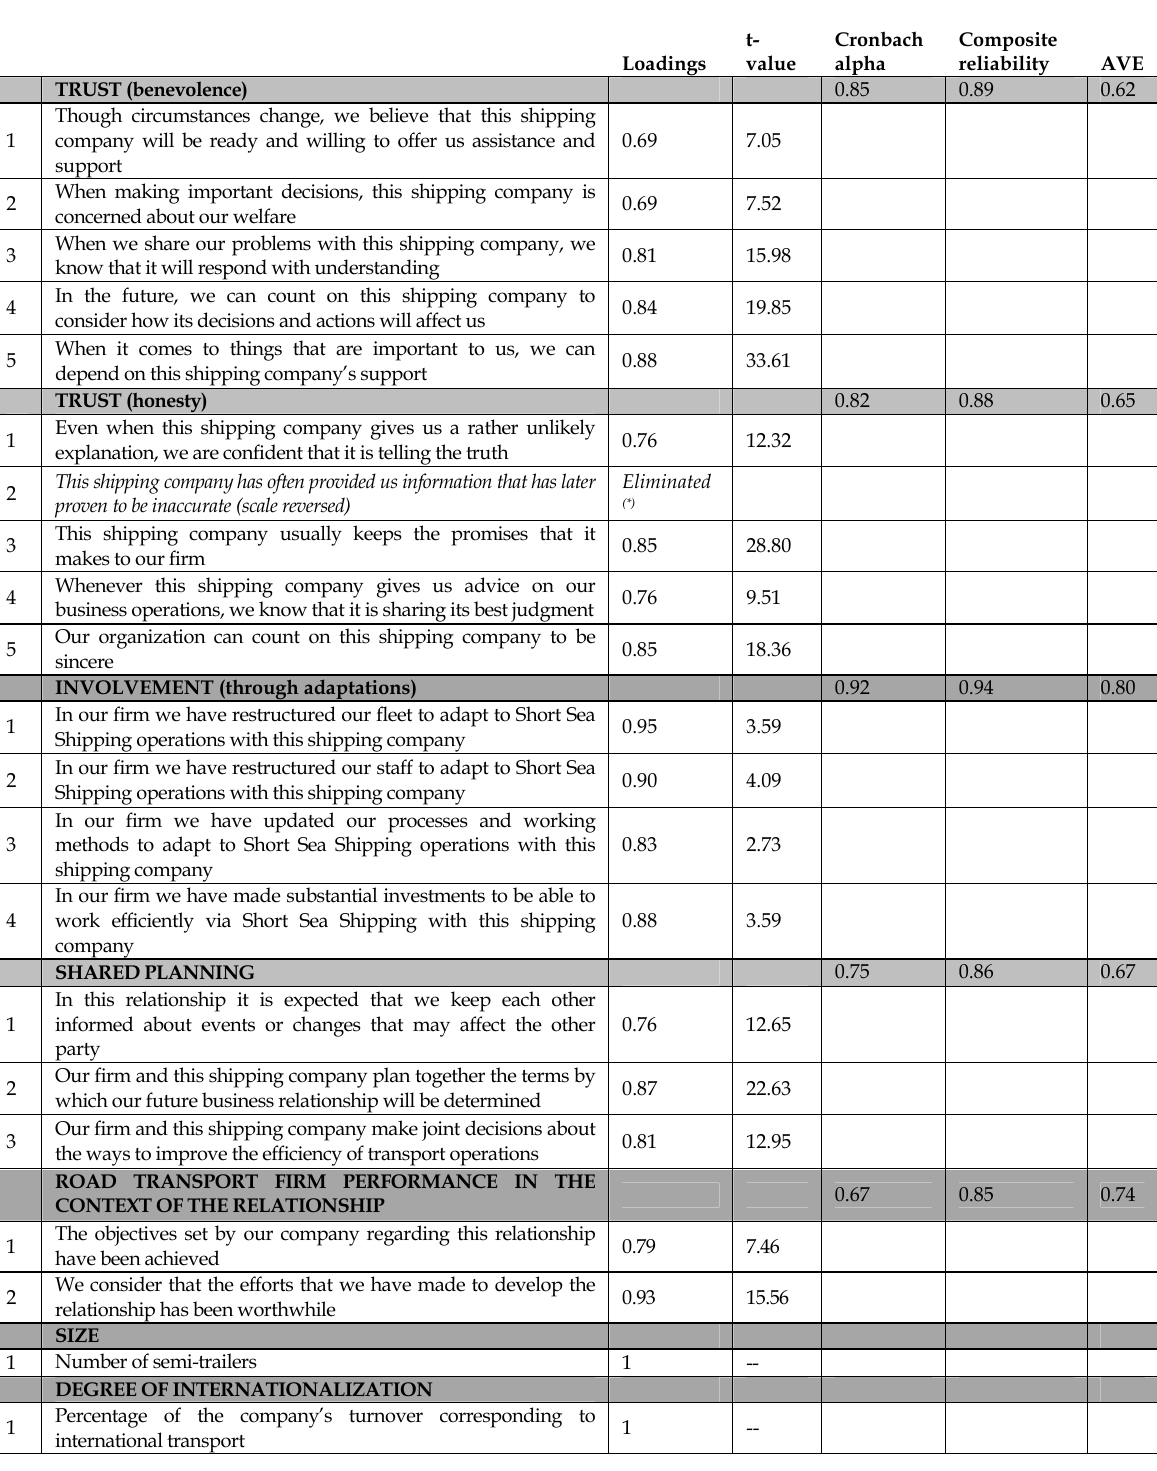
Table 1. Reliability and validity of the measurement model